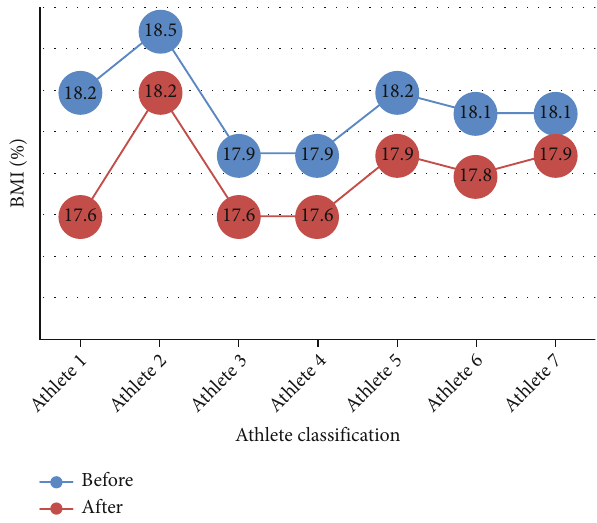
Figure 5: Changes in body fat percentage of